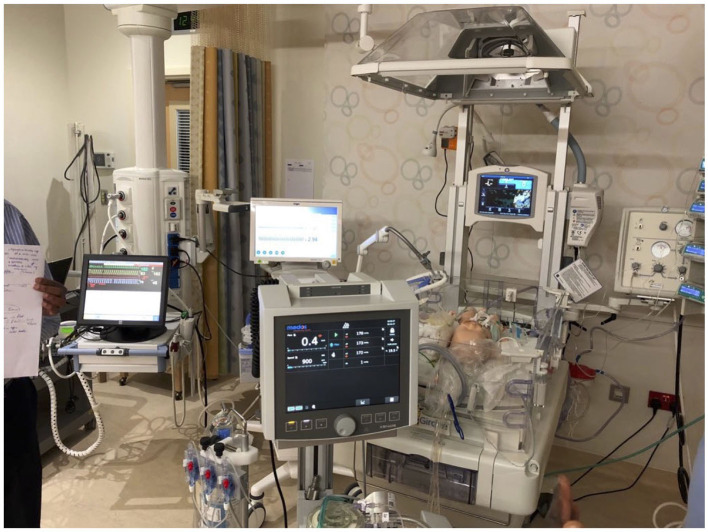
Wet lab training/simulation.